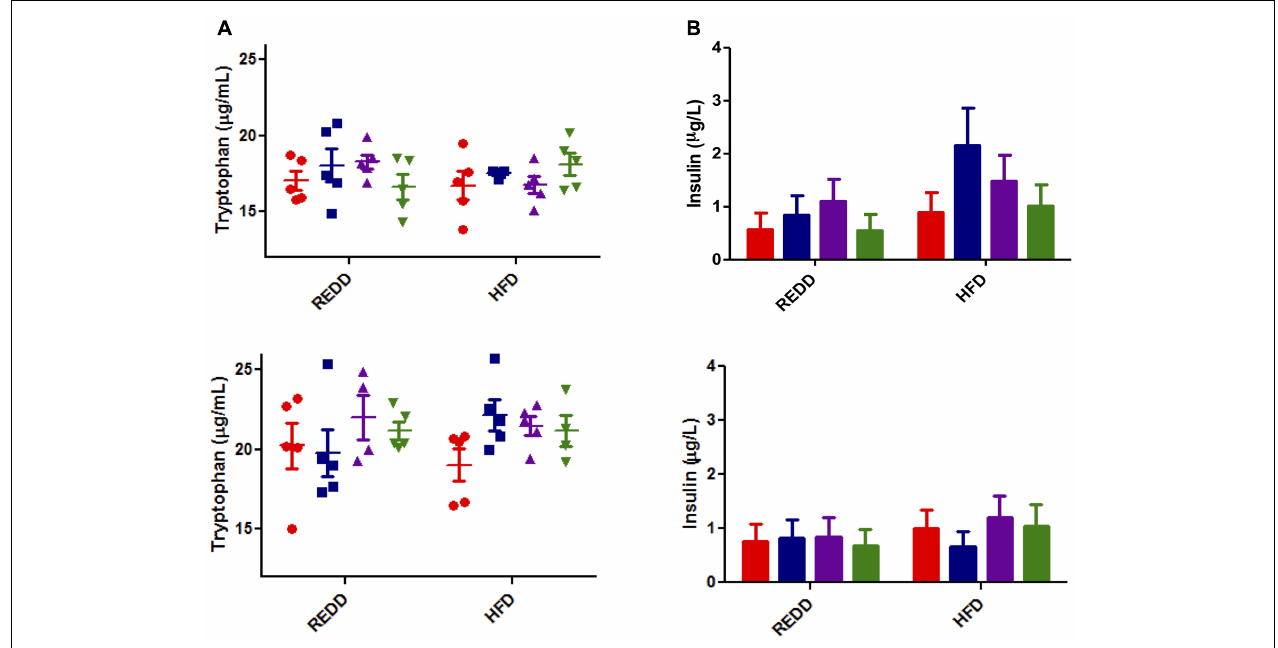
FIGURE 7 | Analysis of mTORC1 inducers. (A) Tryptophan was quantified by LC-HRMS/HRMS from serum for male (top) and female (bottom). Red circle, control; blue square, blueberry extract; purple triangle, L. johnsonii ; green triangle, blueberry extract + L. johnsonii . (B) Serum insulin was quantified by ELISA according to the manufacturers instructions for male (top) and female (bottom). For all insulin groups, n = 5. Red bar, control; blue square, blueberry extract; purple bar, L. johnsonii ; green bar, blueberry extract + L. johnsonii . Numerical data are summarized as means ± SEM. REDD, reduced energy density diet; HFD, high fat